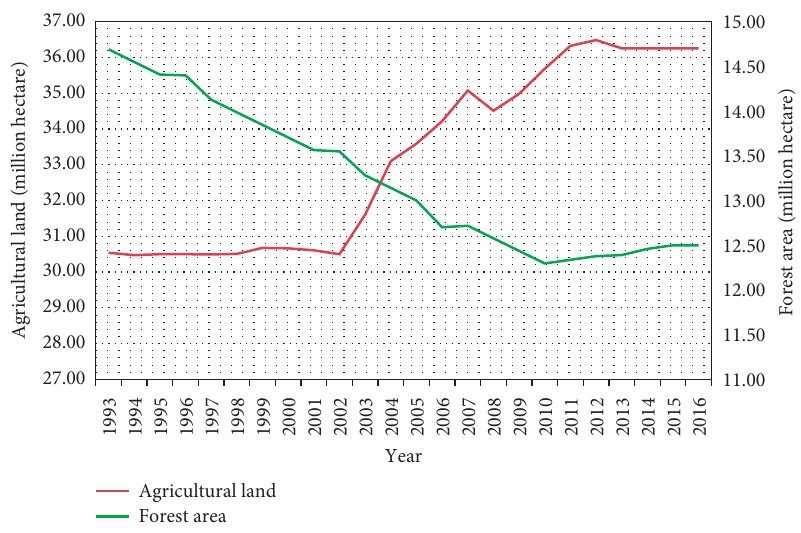
Figure 2: Forest cover decline and agricultural land expansion in Ethiopia between 1993 and 2016